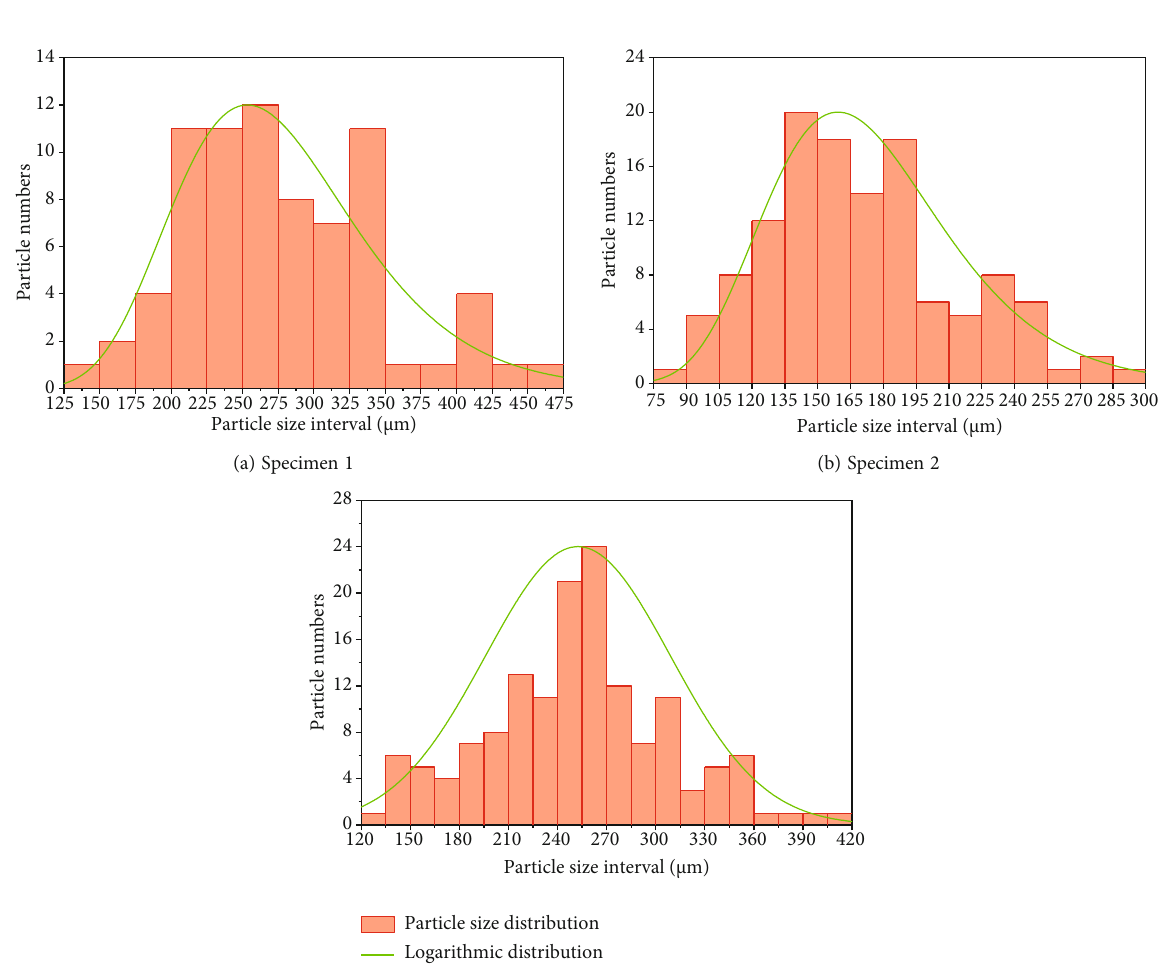
Figure 5: Particle size distribution and optimal probability distribution of the mineral particles in three oil sand